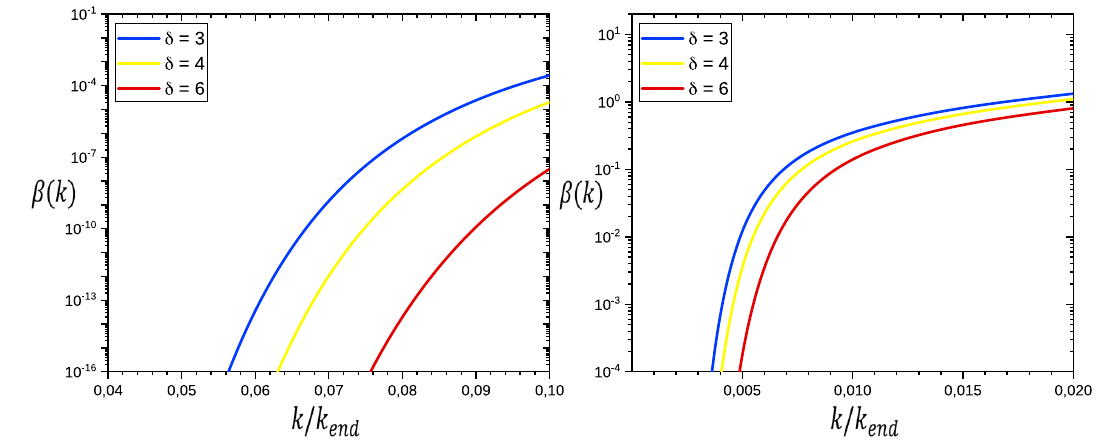
Fig. 5 The fraction of the total energy density collapsing into PBH as functions of dimensionless wavenumber k / k end for δ = 3 (blue-line), δ = 4 (yellow-line) and δ = 6 (red-line). The left panel presents the case of m Δ t = 50 , while in the right panel is for m Δ t =